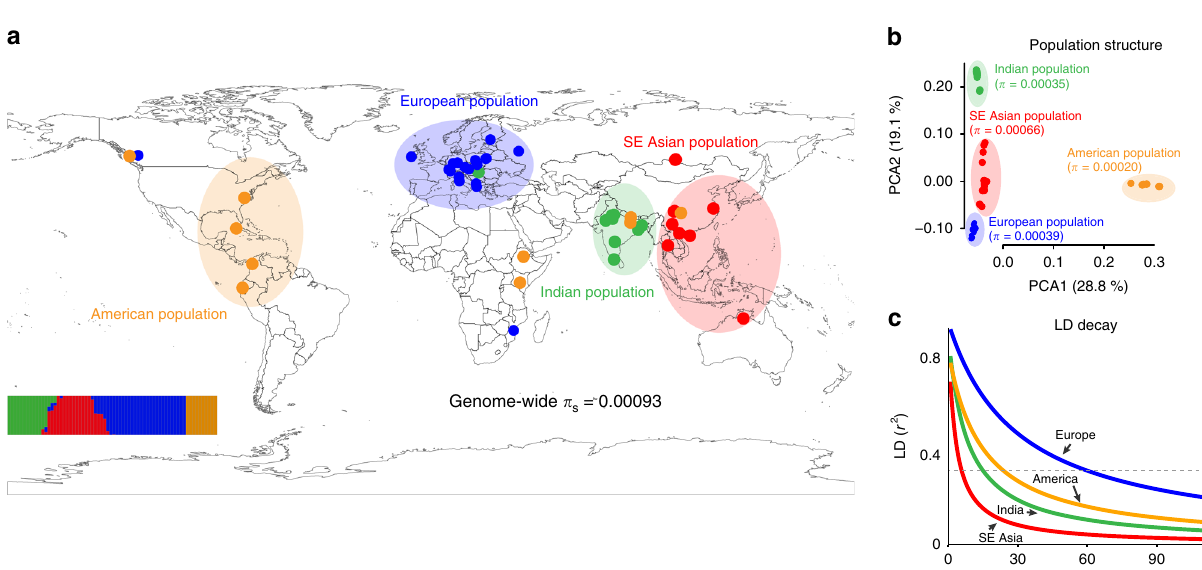
Fig. 1 Nucleotide diversity, population structure and linkage disequilibrium in S. polyrhiza . a Geographic distribution of the 68 sequenced samples, colored according to population structure. The insert at the lower left corner shows the results from the STRUCTURE analysis using genome-wide polymorphisms. Each colored line refers to an individual and the Y -axis refers to the likelihood of membership to each cluster. Genome wide π s refers to average pairwise nucleotide diversity at synonymous sites. SE: Southeast. b Principal coordinate analysis (PCA) based on genome-wide nucleotide diversity data. Average pairwise nucleotide diversity ( π ) calculated from all sites is shown for each population. c Decay of linkage disequilibrium (LD) with physical distance in four populations. The dashed line indicates an LD value of r 2 = 0.33. Data are deposited in fi gshare 58